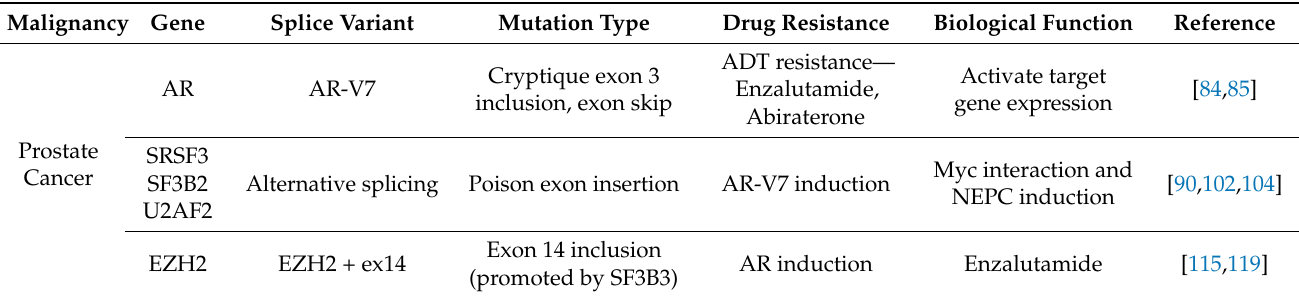
Table 3. AS and effects on drug resistance in prostate